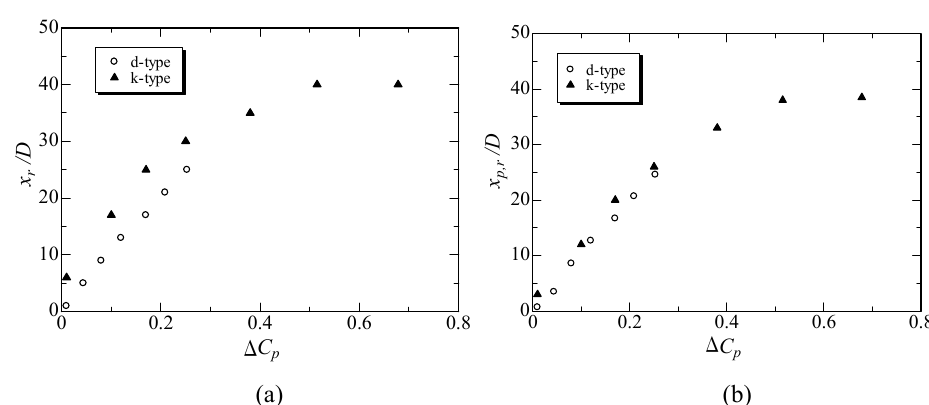
Fig. 11 (a) Recovery length of the system depend on effective pressure drop; (b) Length between peak and recovery condition varying in effective pressure